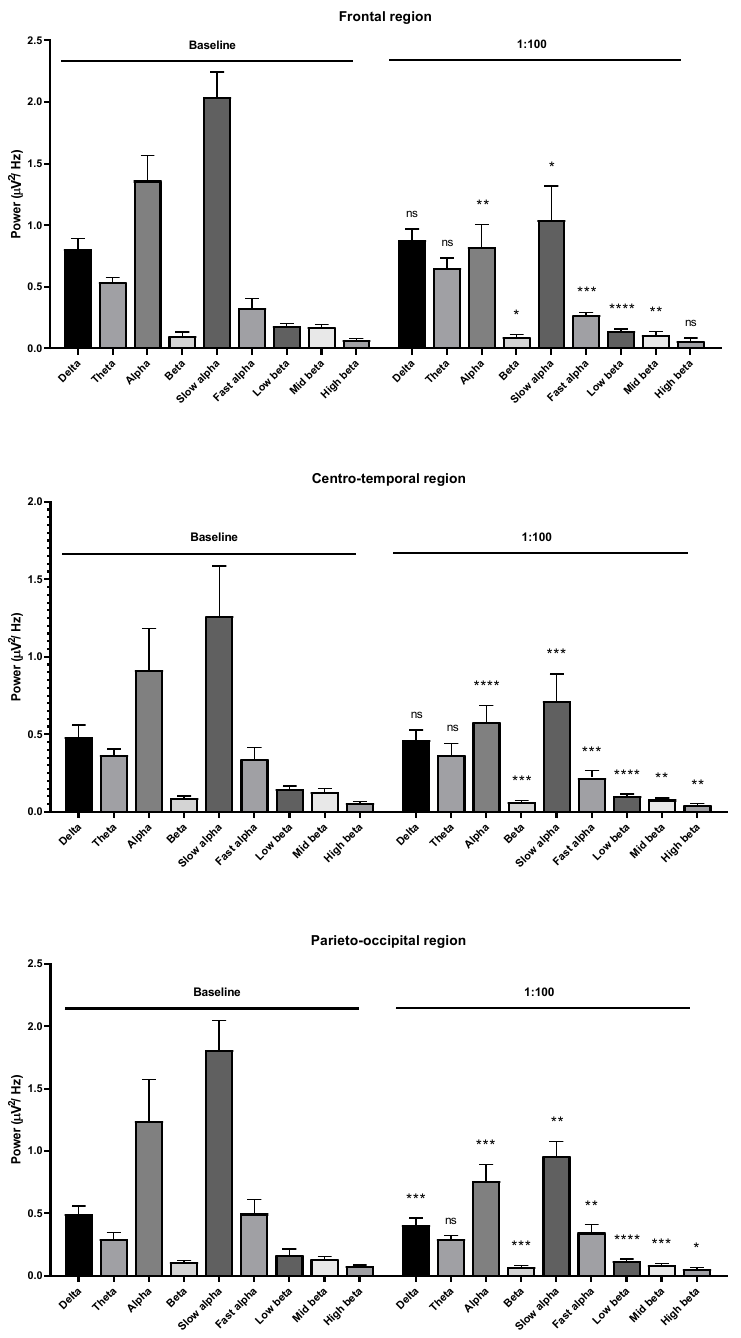
Figure 4. Effects of Litsea cubeba oil inhalation at a 1:100 dilution on the delta, theta, alpha, beta, slow alpha, fast alpha, low beta, mid beta, and high beta wave powers: ( upper ) frontal region; ( middle ) centro-temporal region; ( lower ) parieto-occipital region. p value: not significant (ns) ≥ 0.05, * < 0.05, ** < 0.01, *** < 0.001, and **** < 0.0001.